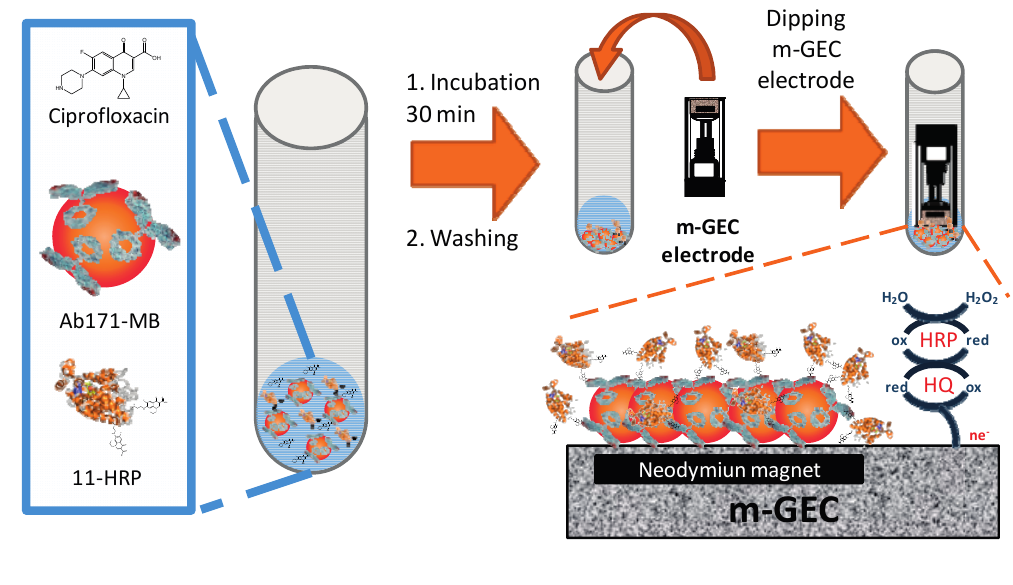
Figure 1. Scheme of the AMIS procedure for fluoroquinolones. Firstly, ciprofloxacin standards, Ab171-MB suspension and 11-HRP solution were mixed and incubated for 30 min with gentle stirring. After three washing steps using PBST buffer, performed with the aid of a magnetic rack, the modified magnetic beads are captured by the m-GEC. Then, the electrode is transported to the electrochemical cell using a three-electrode setup for the amperometric